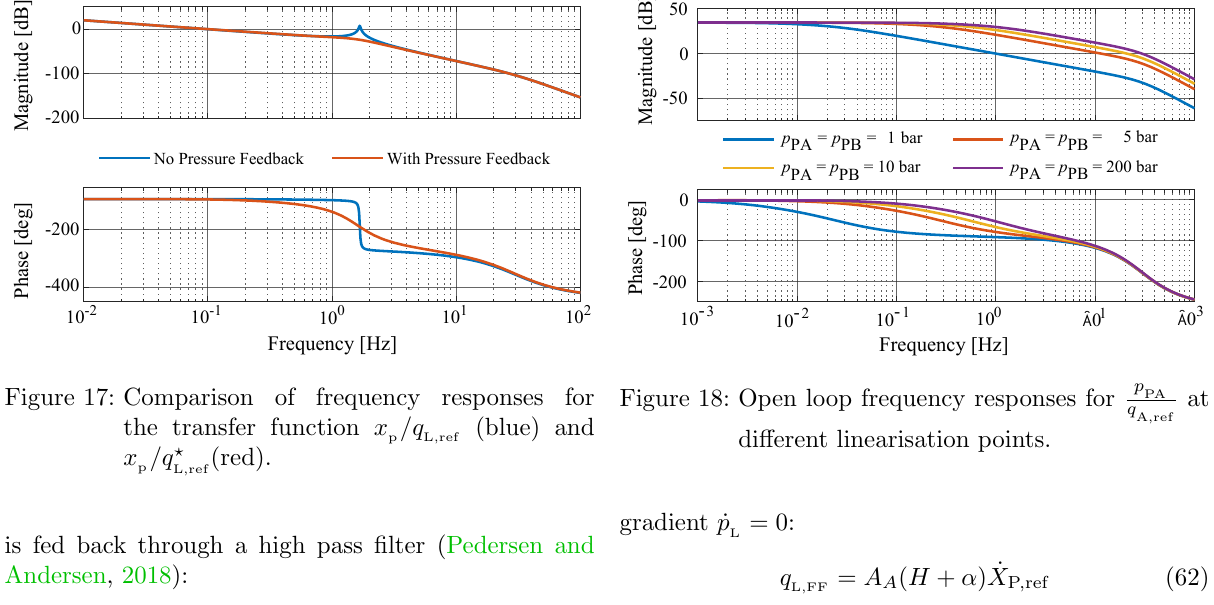
/q (blue) and p L,ref